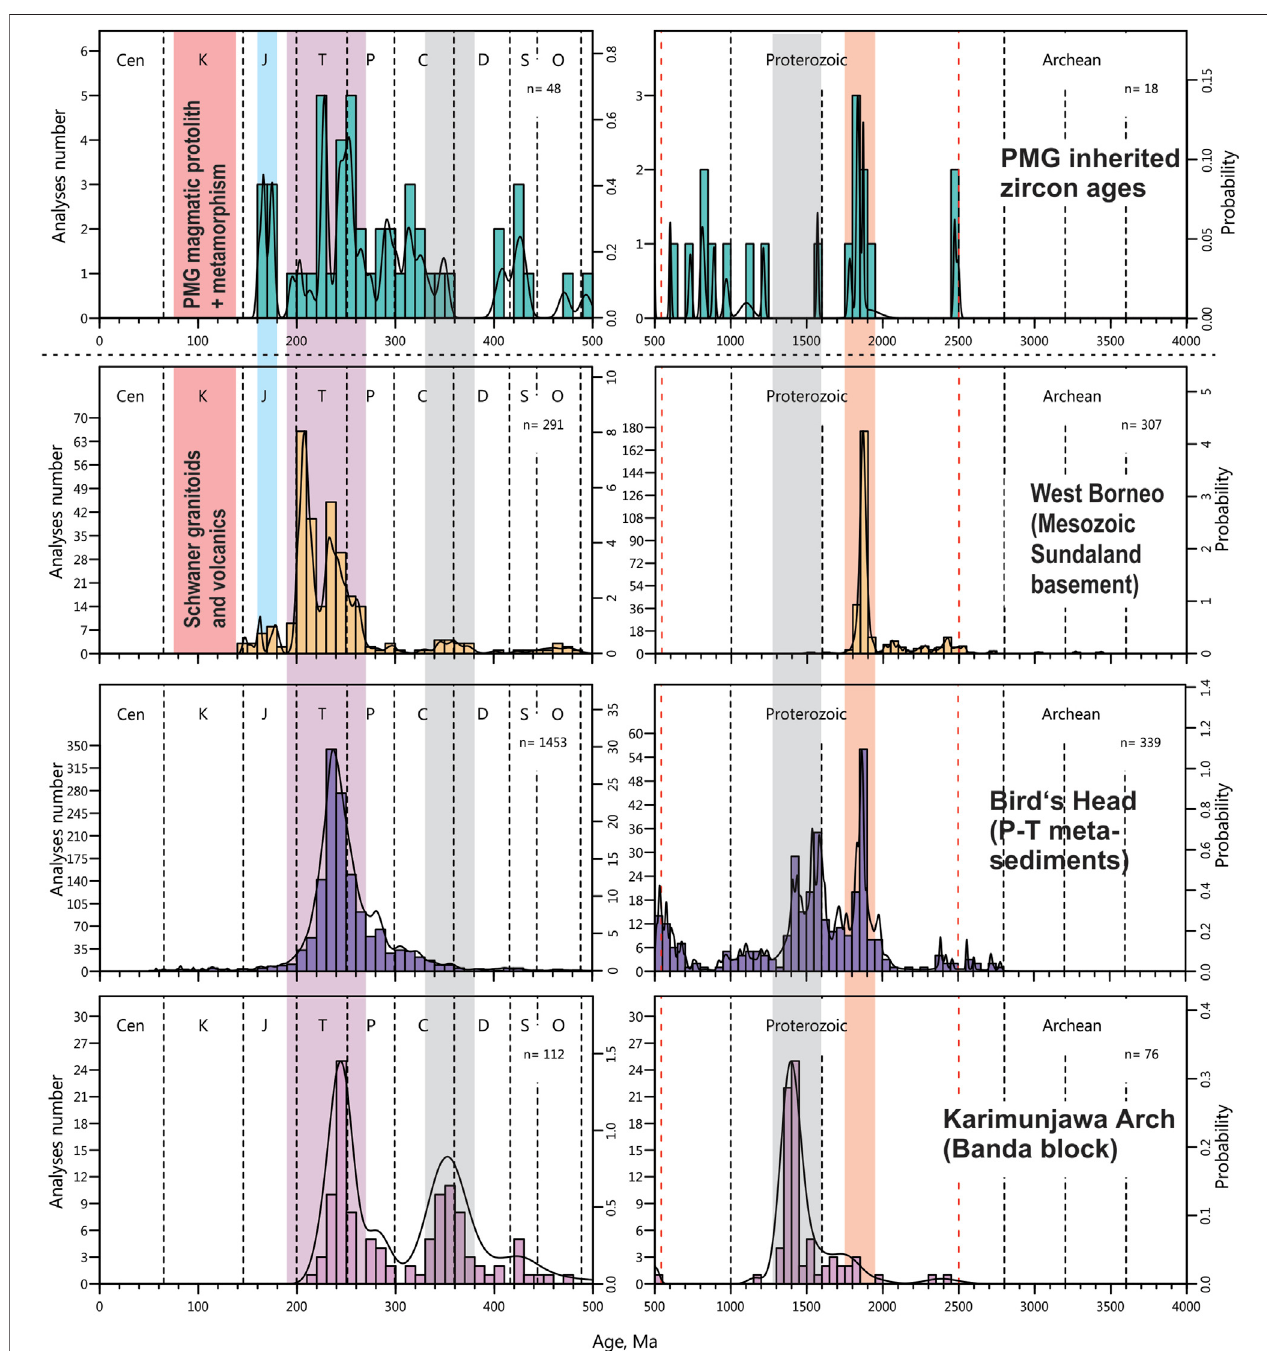
FIGURE 17 | Display of inherited zircon ages of the Pinoh Metamorphic Group and comparison to the Karimunjawa Arch (Banda Block) (data from Witts et al., 2012),Bird ’ sHeadofWestPapua(datafromGunawanetal.,2012),andMesozoicbasementrocksintheWestBorneoprovince(datafromBreitfeldetal.,2017;Hennig et al., 2017). The Karimunjawa Arch and the Bird ’ s Head data are from Triassic rocks, therefore no Jurassic zircons are present.